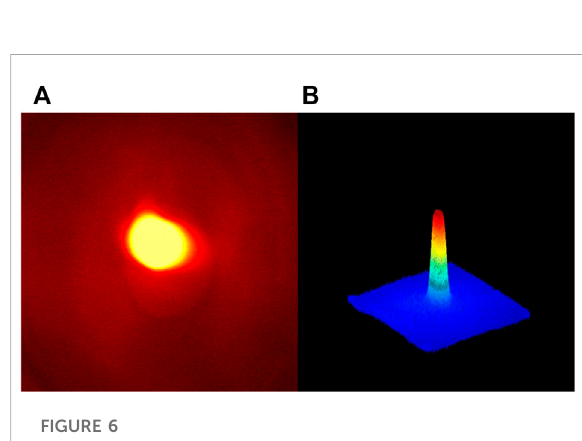
FIGURE 6 (A) FirstcesiummagneticopticaltrapinChina. (B) Coldatoms with 100 μ K and number of 1E+9 at Peking University in